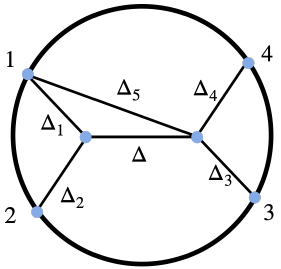
Figure 5 . The exchange Witten diagram with one bound